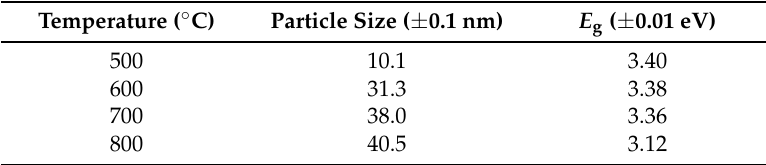
Table 2. The calculated band gap of synthesized TiO 2 at different calcination temperatures.